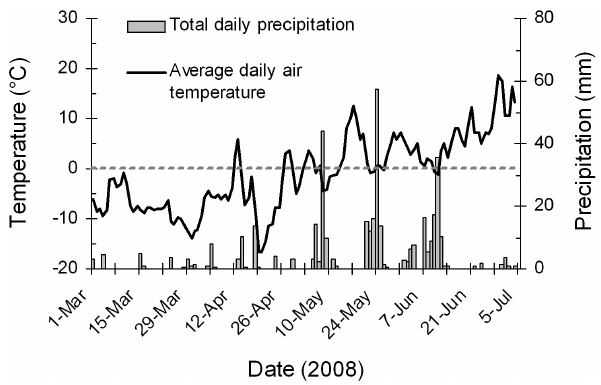
Fig. 2. Air temperature and precipitation at Fisera Ridge during the late winter and spring periods of